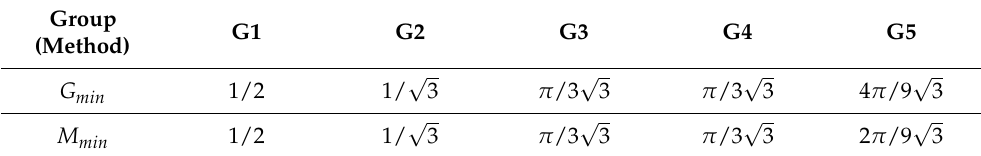
Table 6. The minimum value of voltage gain (G) and modulation index (M) of modulation techniques.